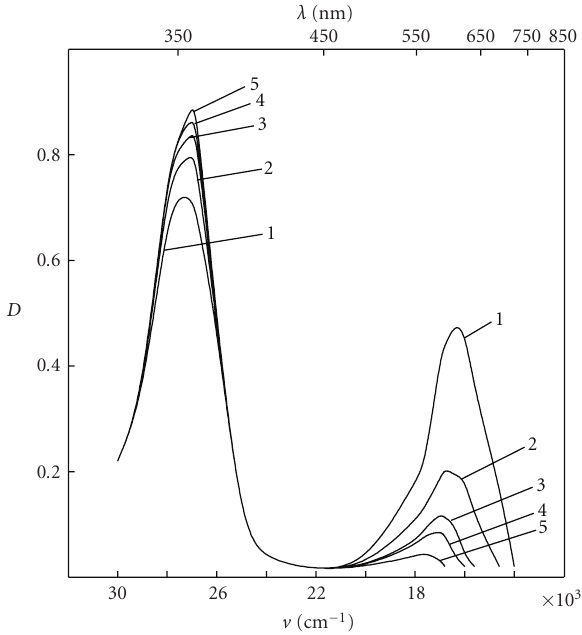
Figure 1: Electronic absorption spectra of the irradiated film of spiropyran 4a : 1, the irradiated form (reverse dark reaction). Time